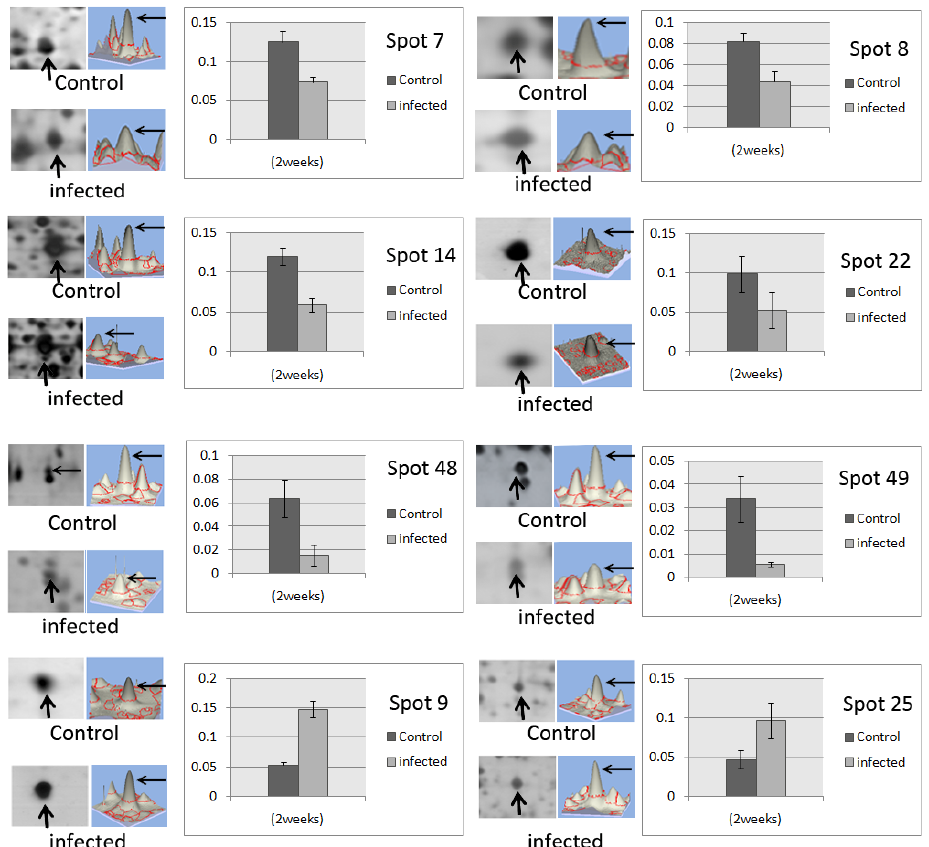
Figure 3. Changes in abundance of oil palm proteins harvested at two weeks after G. boninense infection. Histograms demonstrate mean % volume contribution of protein spot. Error bars are standard deviation of the average spot